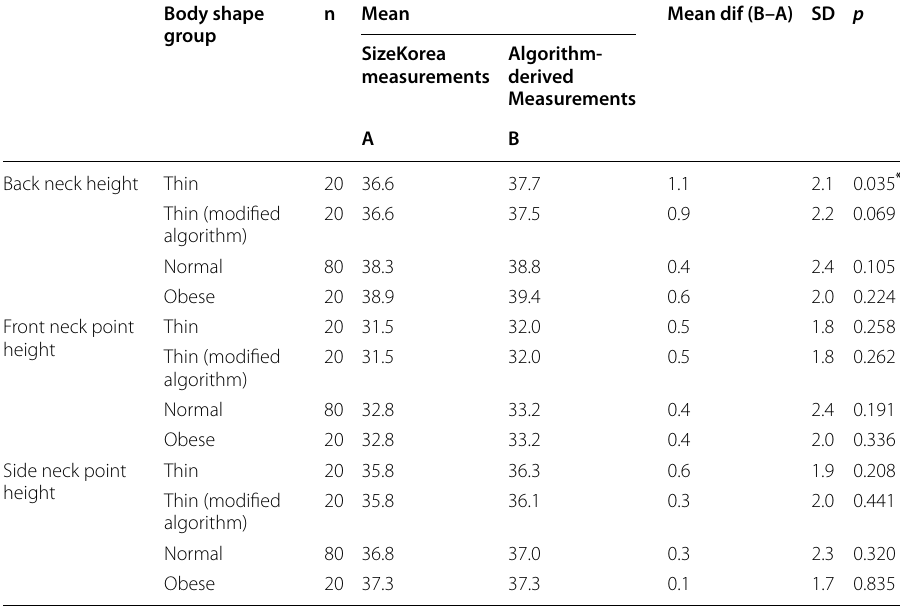
Table 5 The t -test results between the SizeKorea measurements and the algorithm measurements for the neck point height of the body type groups divided by BMI standards (Unit: